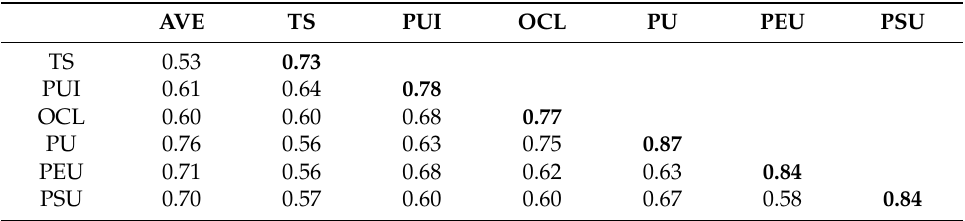
Table 2. Discriminant validity of the TAM-PerLE model.